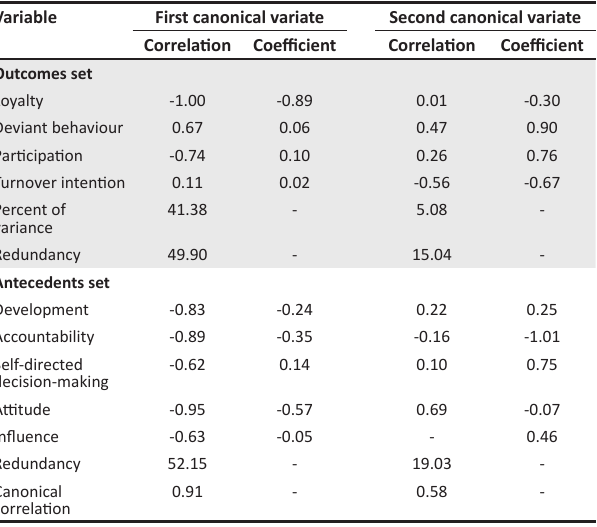
TABLE 3: Results of the canonical analysis: leader empowering behaviour, psychological empowerment, organisational citizenship behaviour and turnover intention.